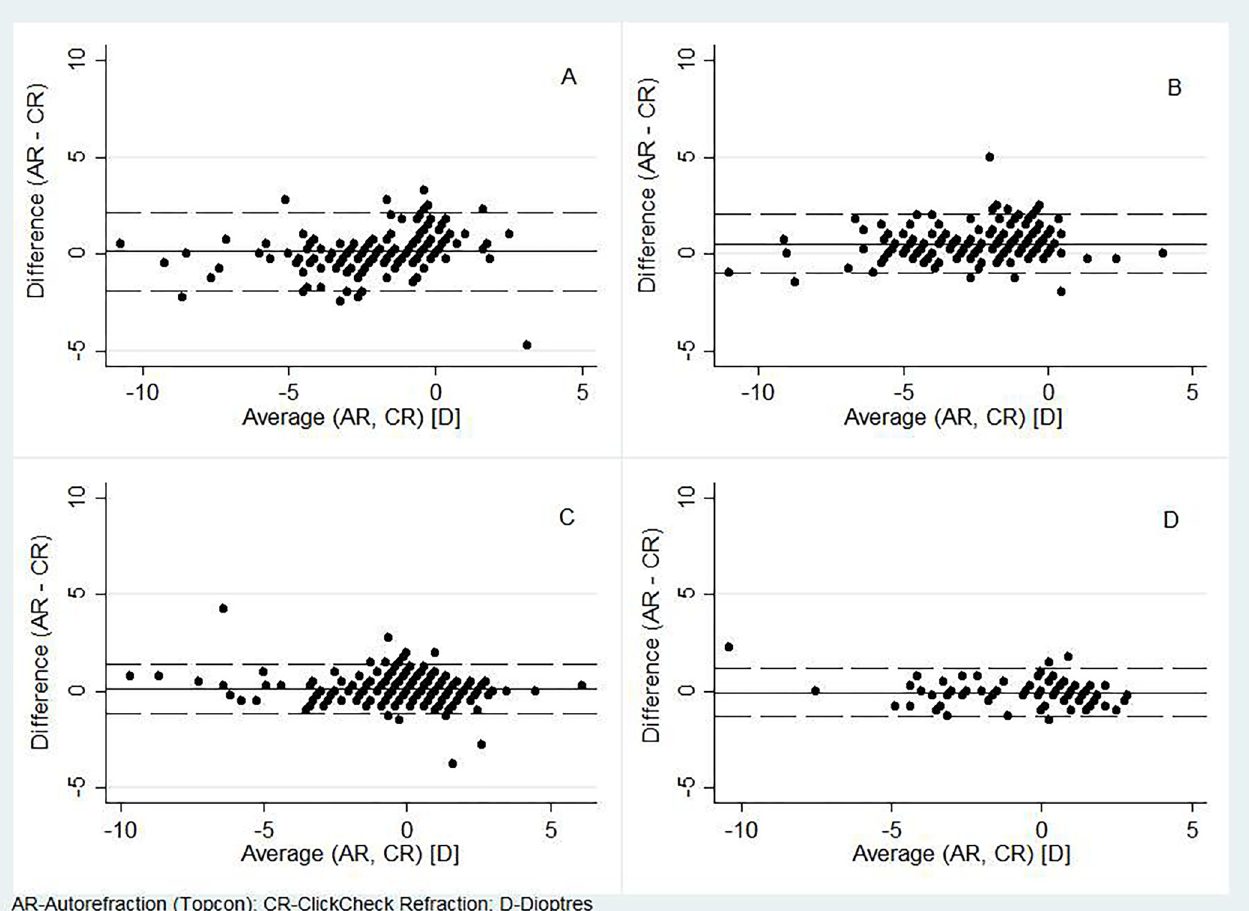
Fig 6. Bland Altman plot comparing the agreement of measurements by conventional autorefractor (AR) and ClickCheck TM refraction (CR) across different age categories A) 7 to 15 years, B) 16 to 40 years, C) 41 to 59 years, D) 60 to 70 years.